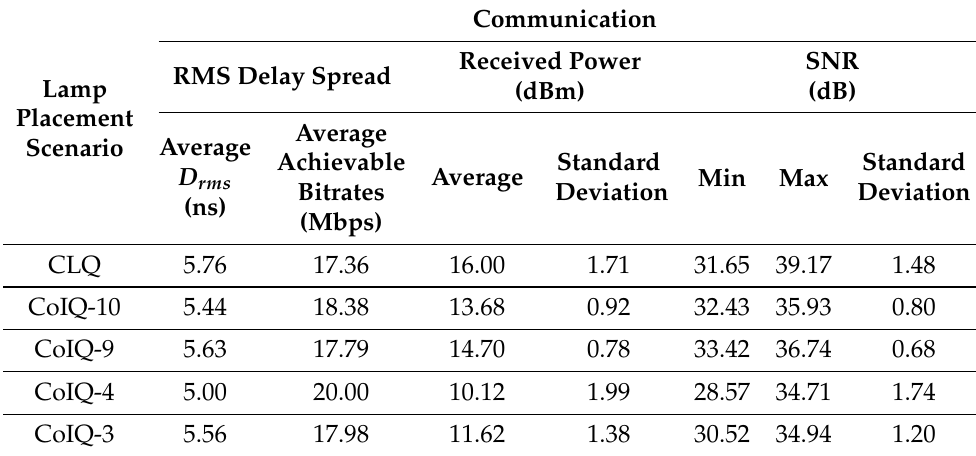
Table 3. Performance Metrics for